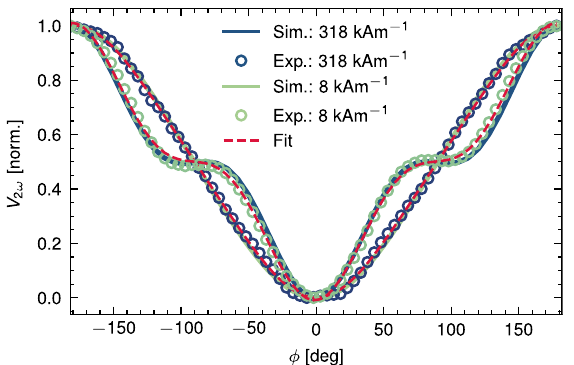
Fig. 6 Second Harmonic Hall voltage detection in angular variation. Hollow dots represent the experiment, solid lines mark the simulation data and a dashed red line denotes the fi t to Eq. (5). The y -axis is normalised. Measurement data was collected from Pt(4.3 nm)/FeCoB(2 nm) device, for two example magnitudes of the external magnetic fi